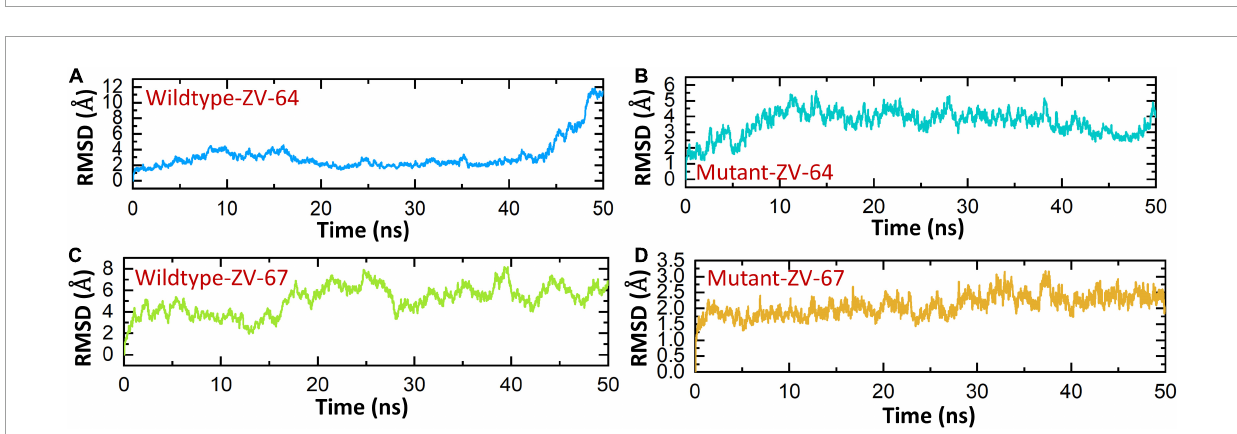
FIGURE5 Calculation of RMSD for all complexes. (A) Wild-type DIII-ZV-64 complex. (B) mutant DIII-ZV-64 complex, (C) wild-type DIII-ZV-67 complex, and (D) mutant DIII-ZV-67 complex.